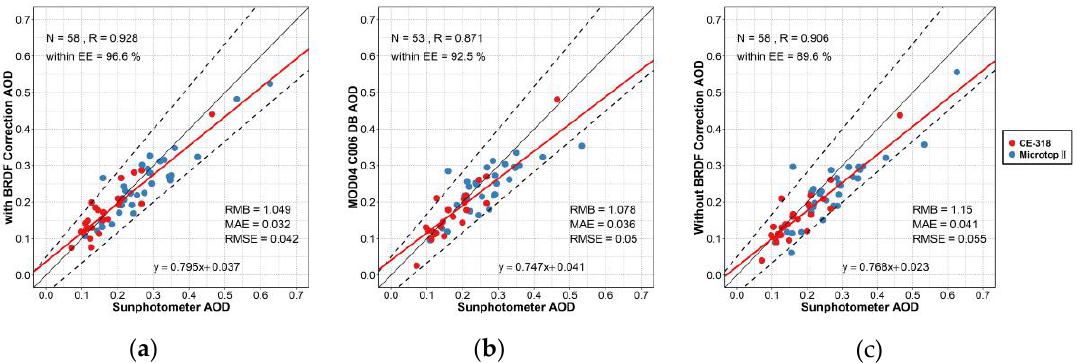
Figure 8. Validation of retrieved AOD from the ( a ) new algorithm (500 m), ( b ) MOD04 C6 DB algorithm (10 km), and ( c ) the new algorithm without angle normalization (500 m) against the ground-based sunphotometer AOD measurements. The black dashed lines are the EE lines, the black solid lines are the 1:1 line and red solid lines are the regression lines.